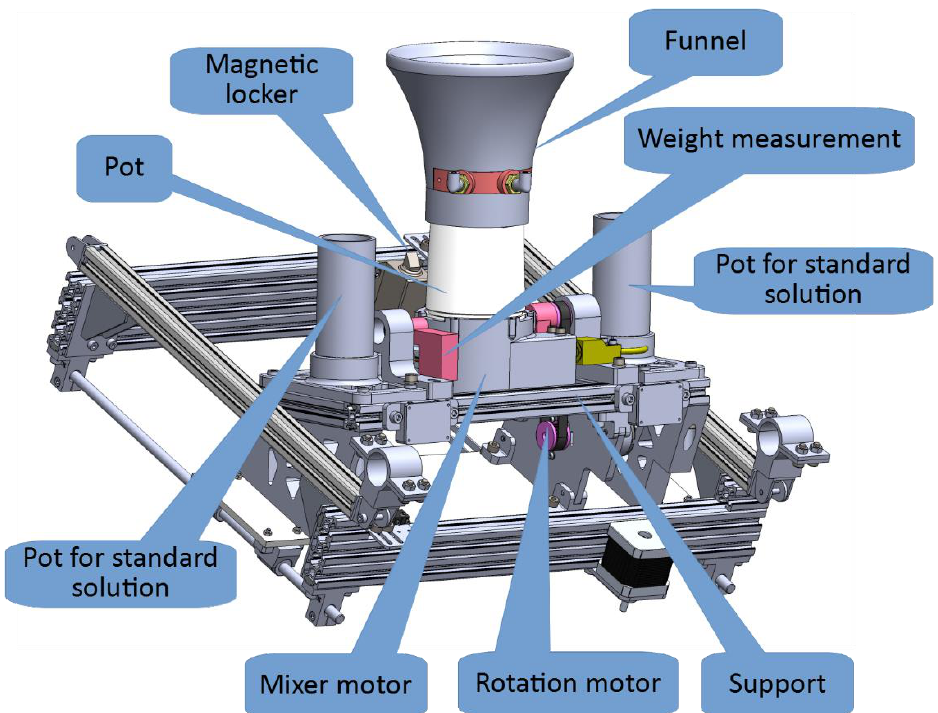
Figure 8. The 3D model of the measurement pot with parts.